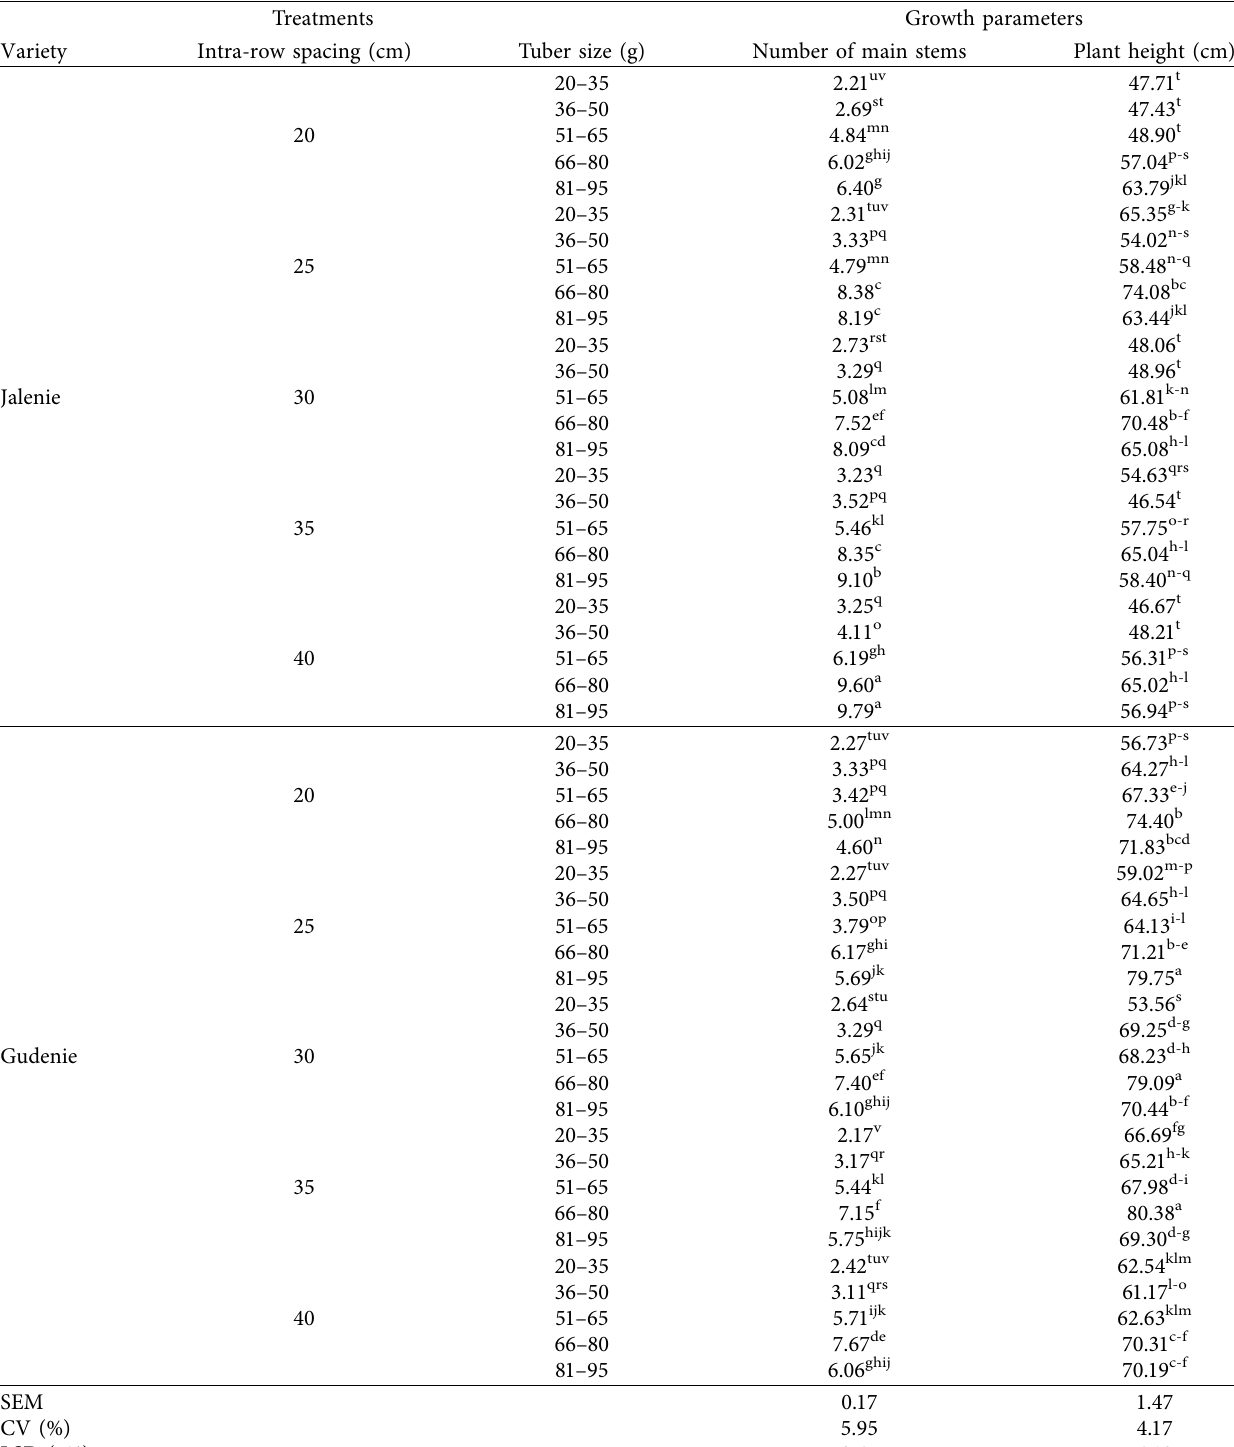
Table 5: Interaction effects of variety, intra-row spacing, and tuber size on growth parameters of potato in 2013/2014 at Nono Benja. Treatments Growth parameters